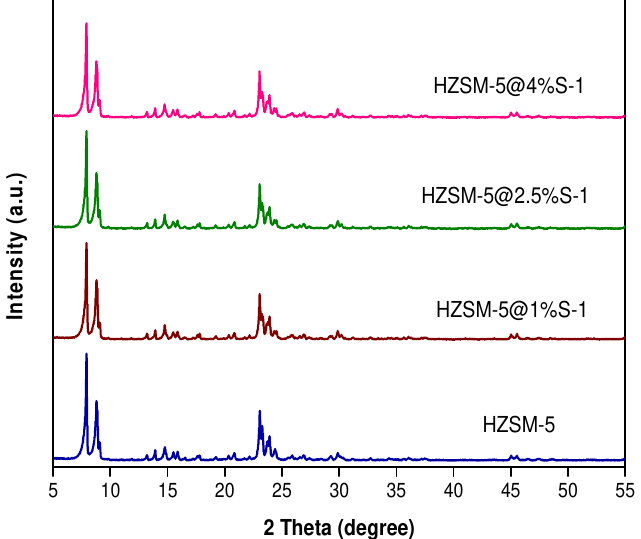
Figure 1. XRD patterns of the as prepared parent HZSM-5 and HZSM-5@silicalite-1 samples.